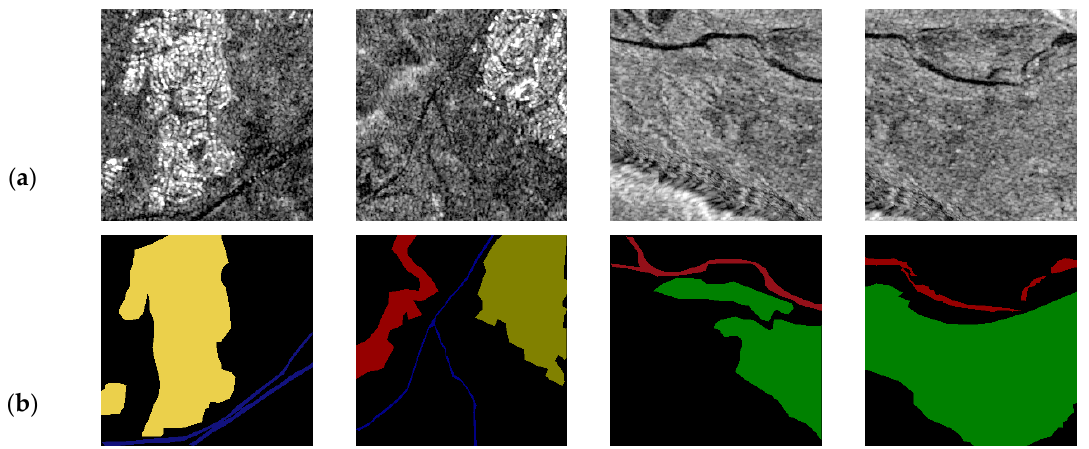
Figure 3. The SAR imagery and its corresponding ground truth: ( a ) SAR imagery; ( b ) ground truth. Remote Sens. 2020 , 12 , x FOR PEER REVIEW 8 of 13